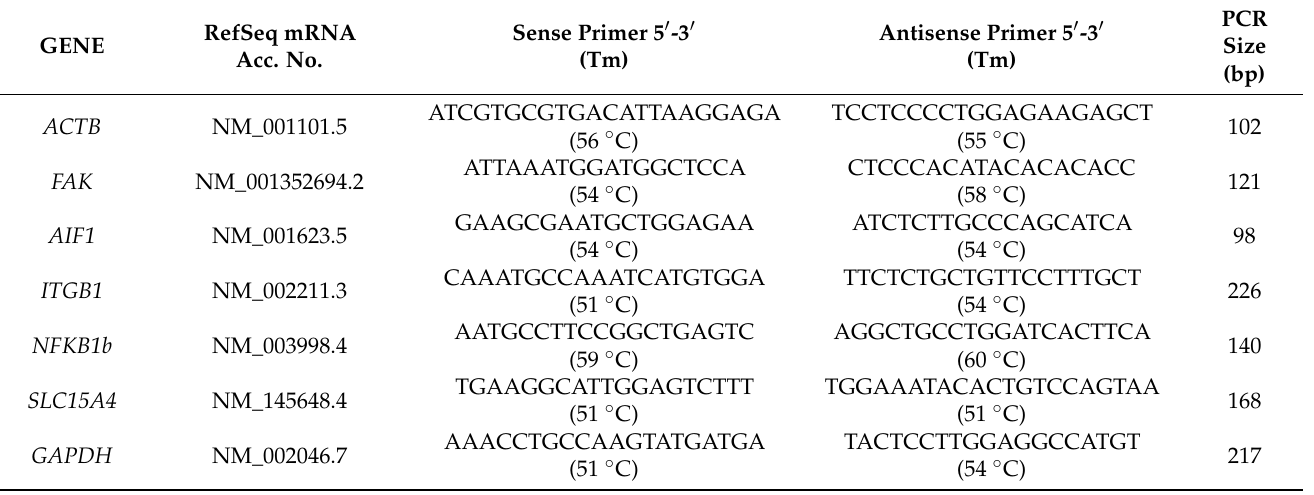
Table 1. Features of primer sequences for qPCR expression analysis . For each gene, the NCBI accession numbers of the mRNA reference sequence (RefSeq mRNA) used for primer design are reported. For each primer, the 5 (cid:48) -3 (cid:48) nucleotide sequence and melting temperature (Tm) are reported. For each mRNA detection, the expected amplicon length is reported (PCR size) in base pairs